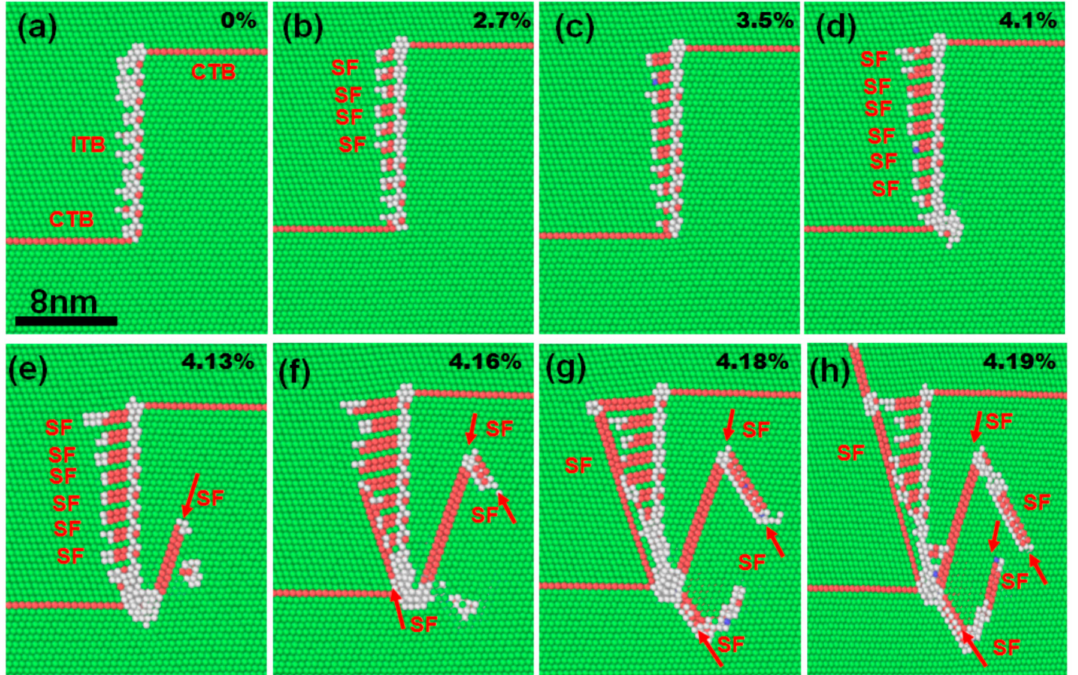
Figure 5. Series of images showing the deformation process of twin-structured Ni nanocrystals: ( a – d ) the partial dislocation at the ITB glides into the FCC lattice on every third (111) plane, leading to periodical sets of short SFs observed at the ITB; ( e ) the ITB serves as a partial dislocation source; ( f – h ) direct observation of partial dislocations emitted from the ITB or the tips of SFs.